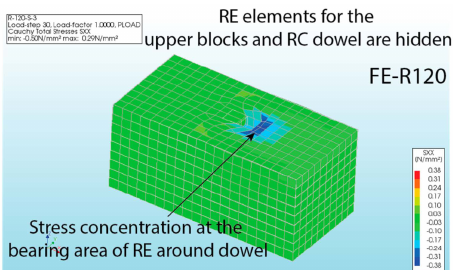
Figure 10. Primary stress for RE element around the RC dowel with stress concentration region around the RC